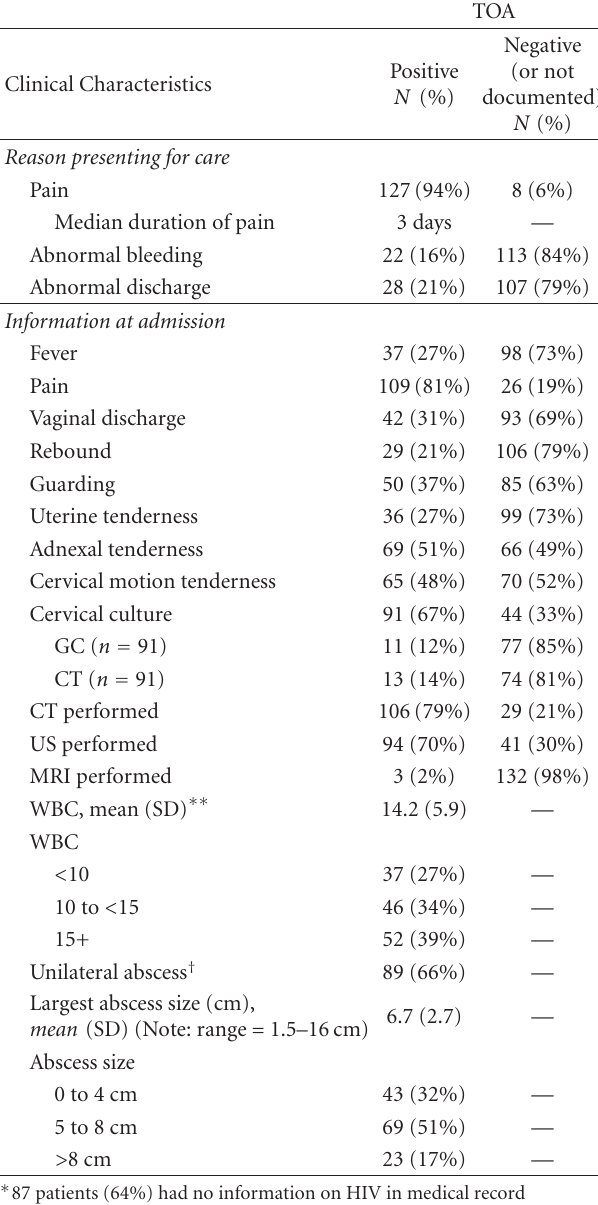
Table 1: History and sociodemographic characteristics of study population.